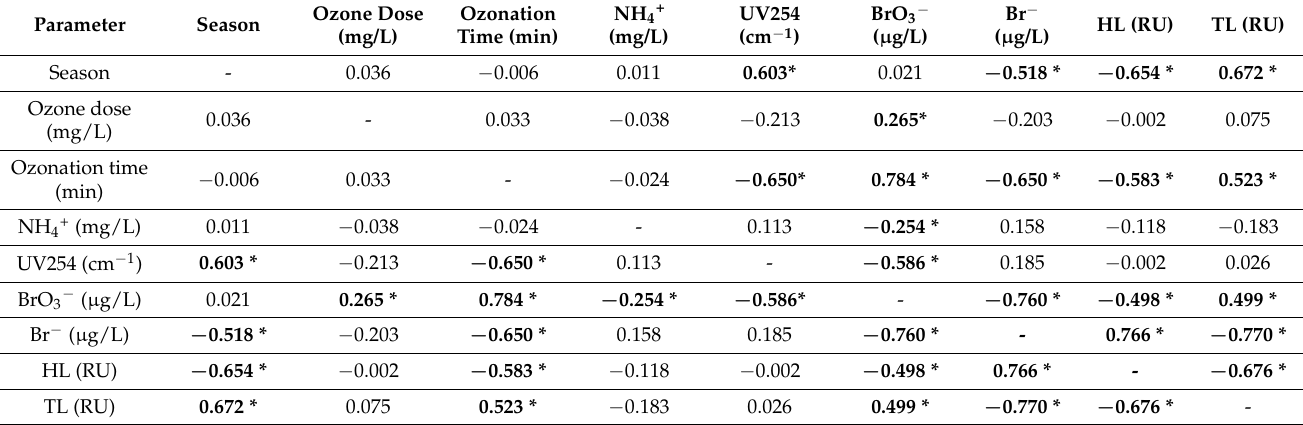
Table 2. The Spearman’s rank-order correlations for all analyzed properties. Values marked bold with * are significant at p <